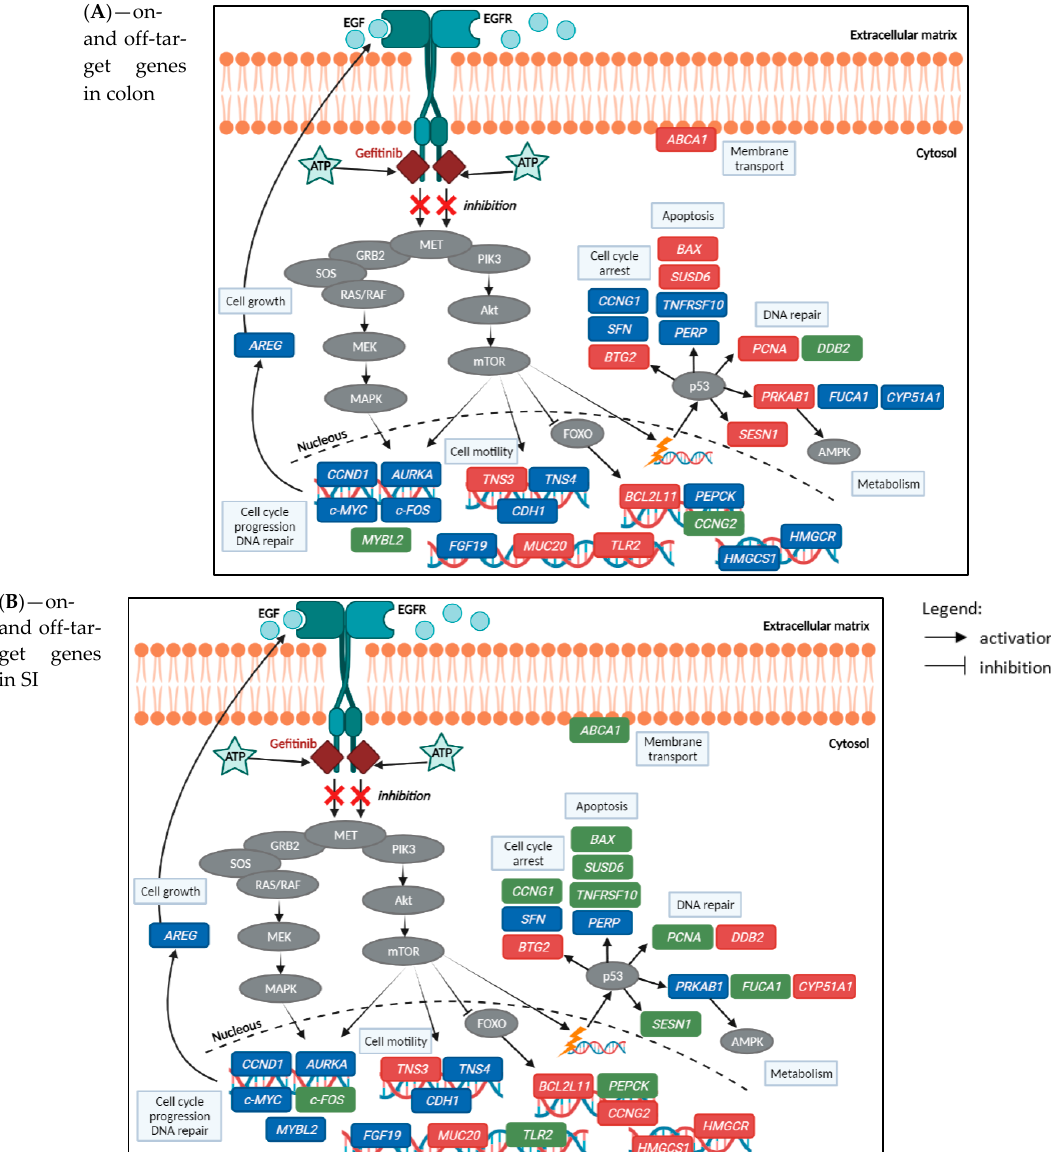
Figure 6. Representation of gefitinib effects on expression levels of on- and off-target genes in the colon ( A ) and SI ( B ) organoids, elucidating the drug’s potential mechanisms of toxicity. For the alterations in the gene expression levels, all treatment conditions were considered. Legend: genes in blue—significantly downregulated; red—significantly upregulated, after Bonferroni correction (adjusted p -value < 0.05); green—not available/not significant; grey—protein expression not available. Image created with BioRender.com (accessed on 26 June 2021).